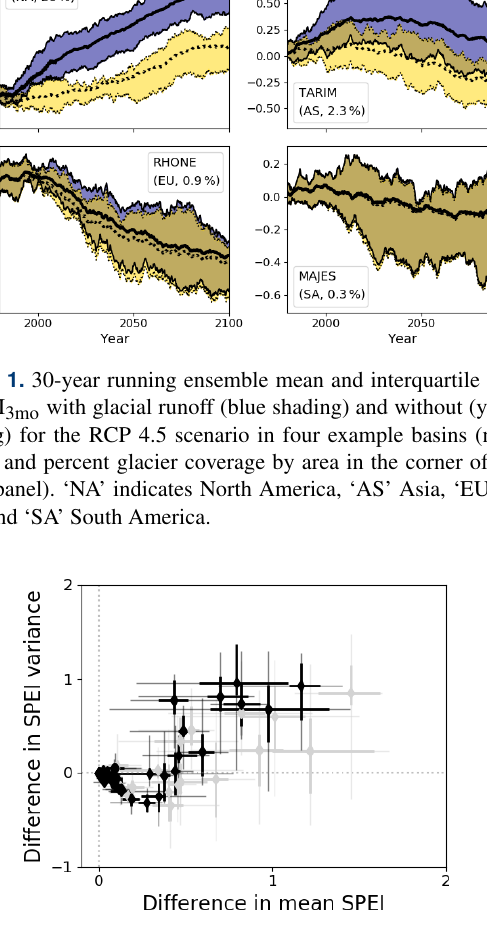
Figure 2. Difference due to explicit accounting of glacial runoff in SPEI 3mo 30-year mean and variance at the end of the 21st century (2070–2100), for climate scenarios RCP 4.5 (black) and RCP 8.5 (gray). A diamond marker for each of the 56 basins analyzed shows the difference in the ensemble mean SPEI 30-year mean ( x -axis) and variance ( y -axis) for each basin. Whiskers show the range of single-GCM results for each basin, with interquartile range in heav- ier